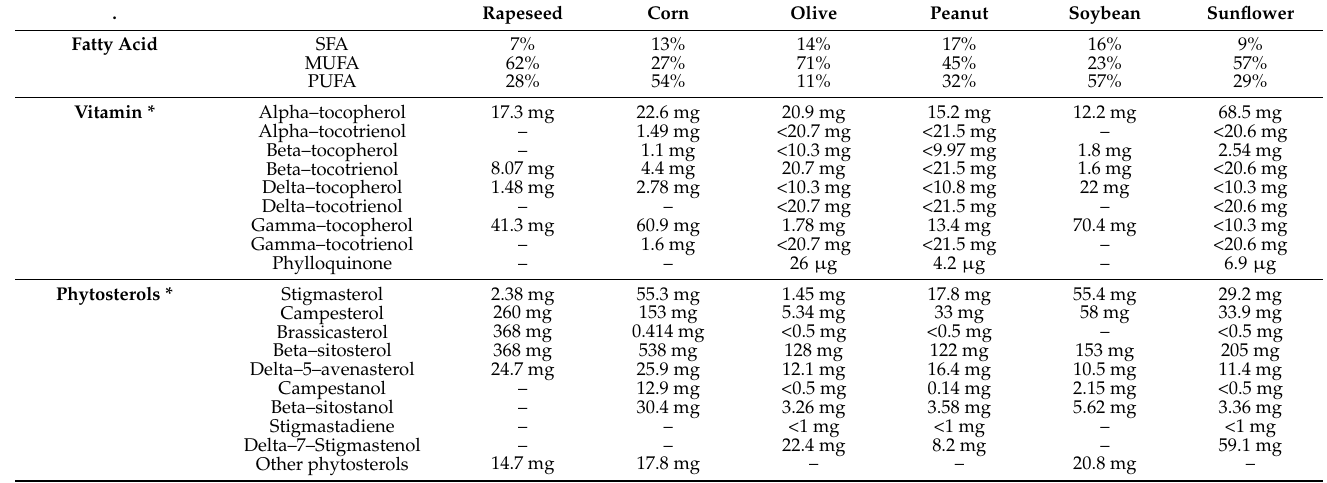
Table 2. Biochemical composition of common vegetable cooking oil